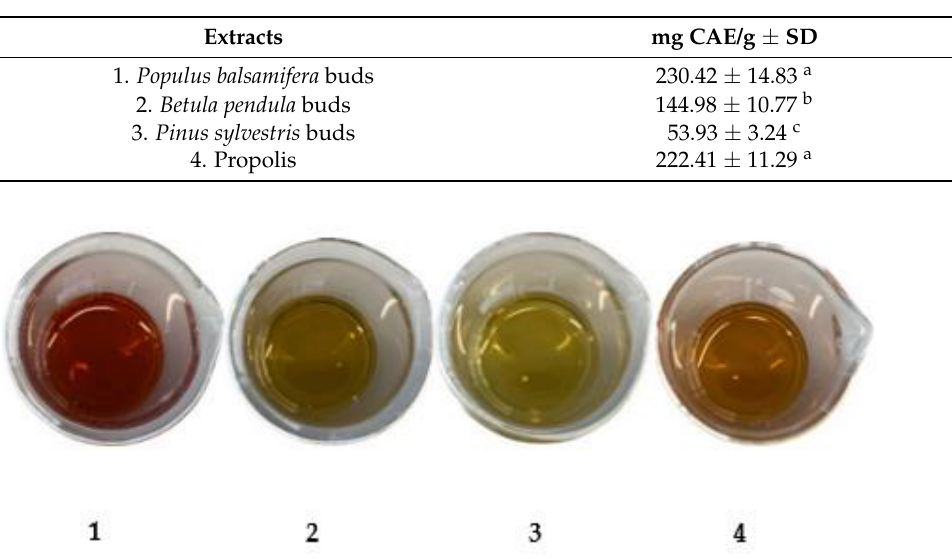
Figure 1. Physical appearance of poplar (1), birch (2), pine (3) buds and propolis (4) extracts.